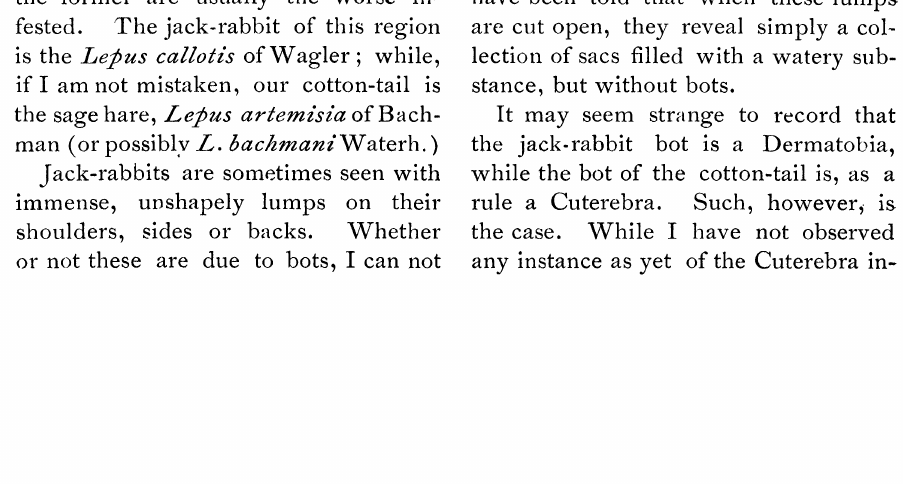
figure it: in my 3rd or 4th vol. (the marbling of the under sides of hind wing is much as in H. semele, but the dark lines are